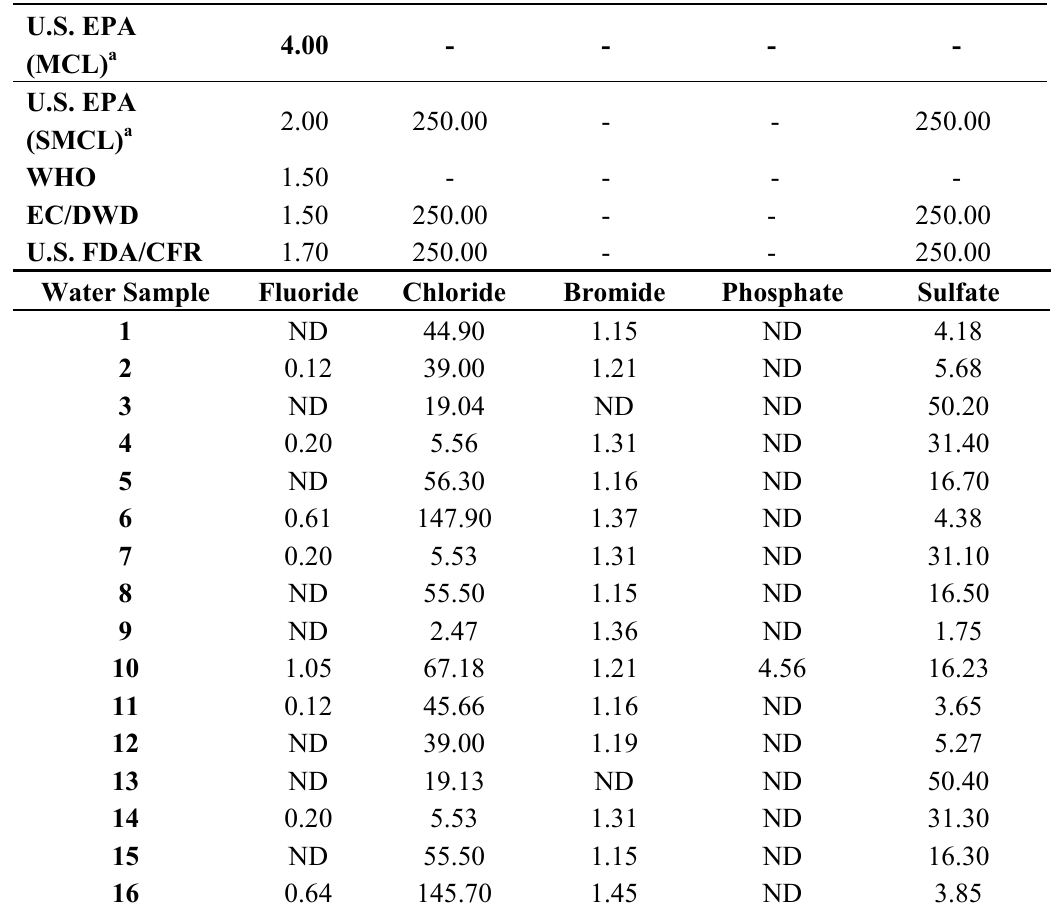
Table 3. Anion contaminant level (mg·L − 1 ) measured in the bottled water samples, compared to the U.S. EPA [19], WHO [16], EC/DWD [22], and U.S. FDA/CFR [20,21] standard